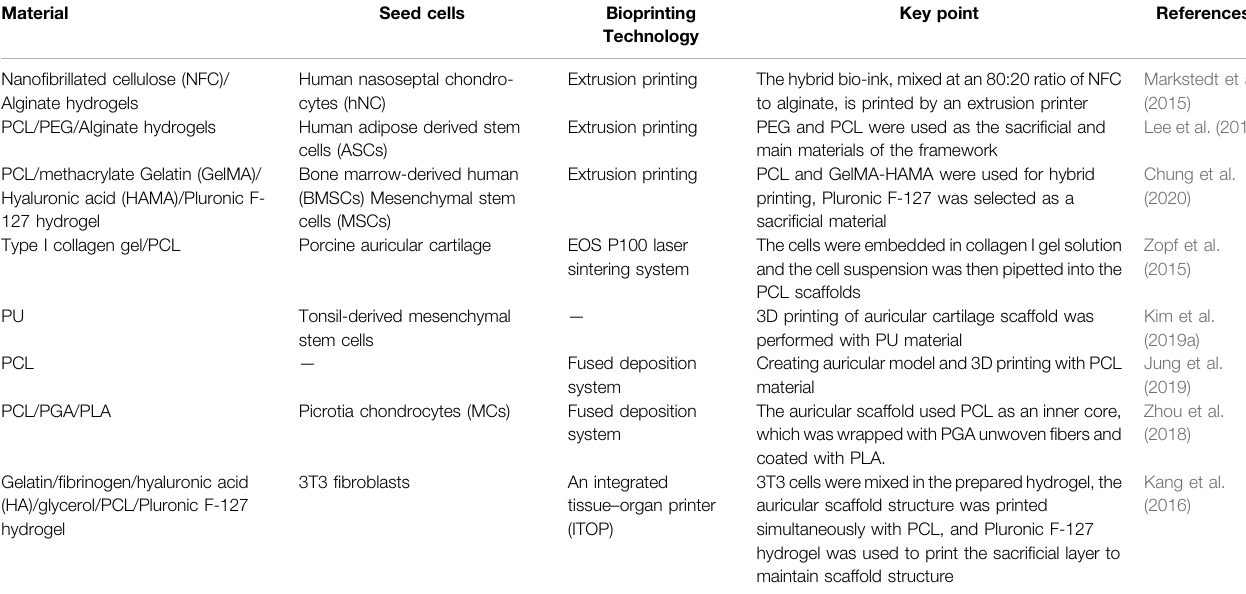
TABLE 1 | Summary of 3D-printed auricular